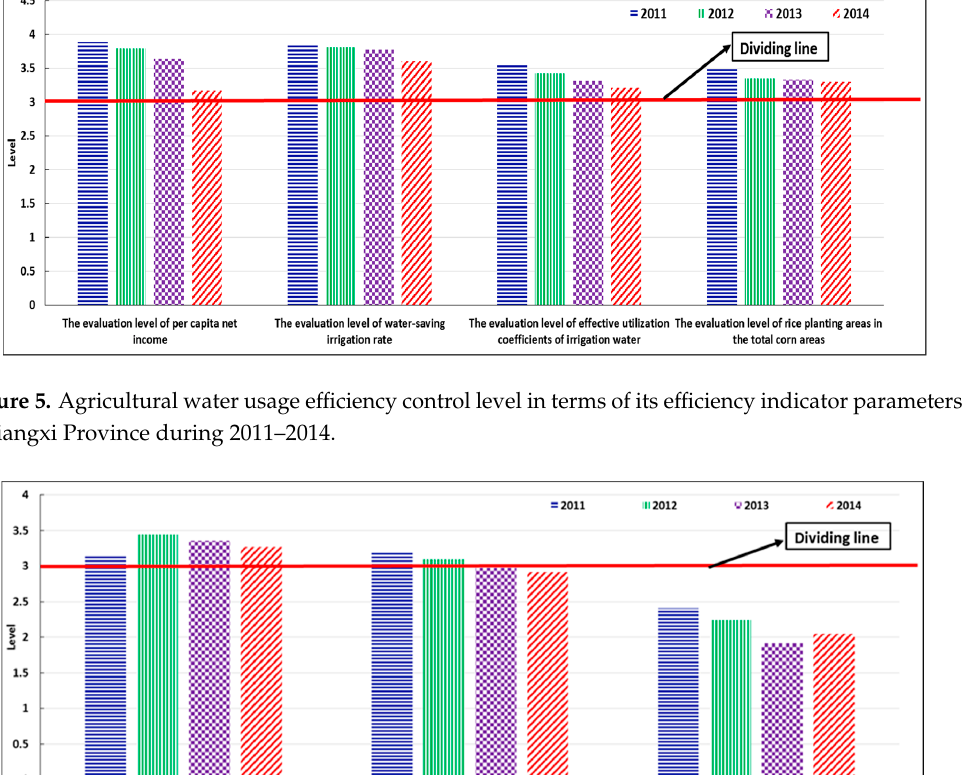
Figure 4. Water usage efficiency control level of Jiangxi Province during 2011–2014.